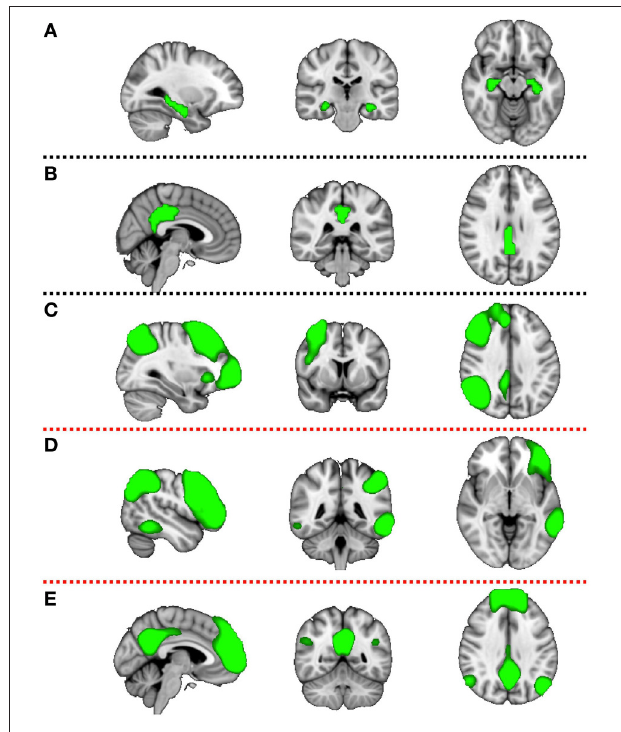
FIGURE 2 | Five masks used in further dual-regression analysis. The figure shows the three most informative orthogonal slices for each mask. Green colored mask is scaled to fit and superimposed onto the 1-mm standard MNI152 standard space template image. Masks are: (A) left and right hippocampus (Montreal Neurological institute (MNI) coordinates x = 3 , y = − 35 , z = 28 ), (B) posterior cingulate cortex ( x = − 28 , y = − 24 , z = − 14 ), (C) right fronto parietal network ( x = 32 , y = 7 , z = 35 ), (D) left fronto parietal network ( x = − 47 , y = − 44 , z = − 4 ), (E) default mode network ( x = − 4 , y = − 53 , z = − 35 ). First two masks (A,B) are binary masks, while last three (C–E) are components produced by the group ICA decomposition of rsfMRI data and converted to Z statistic images via normalized mixture-model fit, and thresholded at arbitrary threshold Z = 3 for visualization purposes.